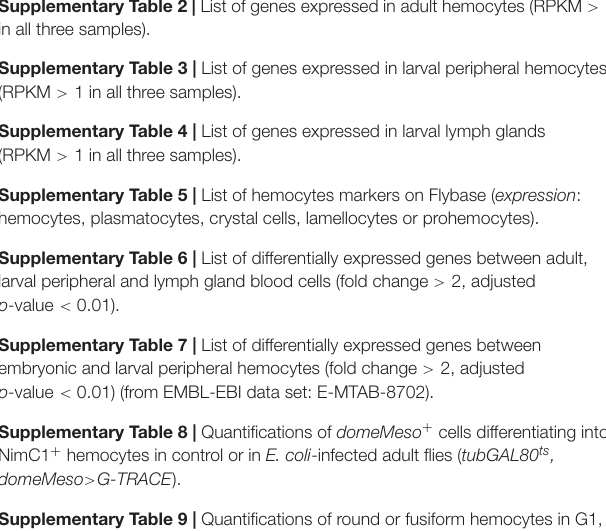
Supplementary Table 1 | List of primers used for qPCR.